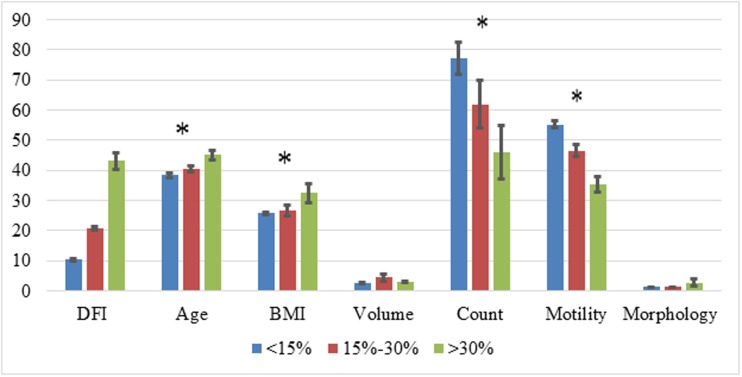
Male demographic parameters and semen analysis in multiple sperm DFI levels +.+ Each parameter is described by specific units in the Y axis as followed: DFI—%; age: years; BMI: Weight in Kilograms / (Height in Meters x Height in Meters); volume—ml; Count: millions sperm cells per ml; motility—% of motile spermatozoa; morphology—normal morphology according to Kruger criteria [22]. *p<0.05.